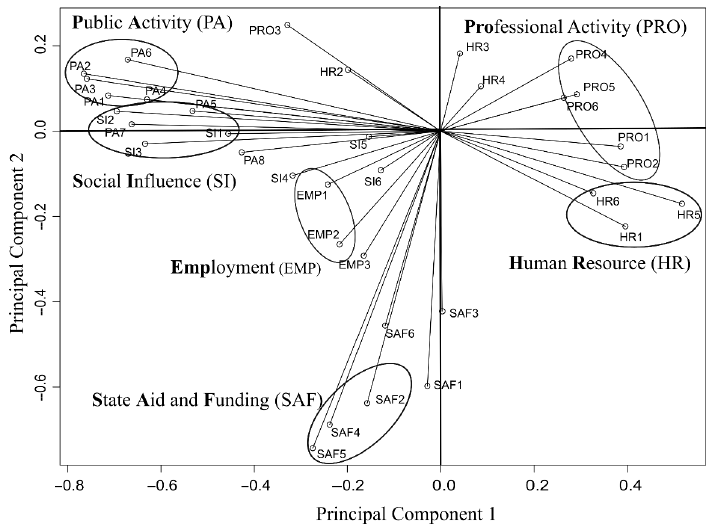
Figure 1. The 2-dimensional solution of the CATPCA method (source: own